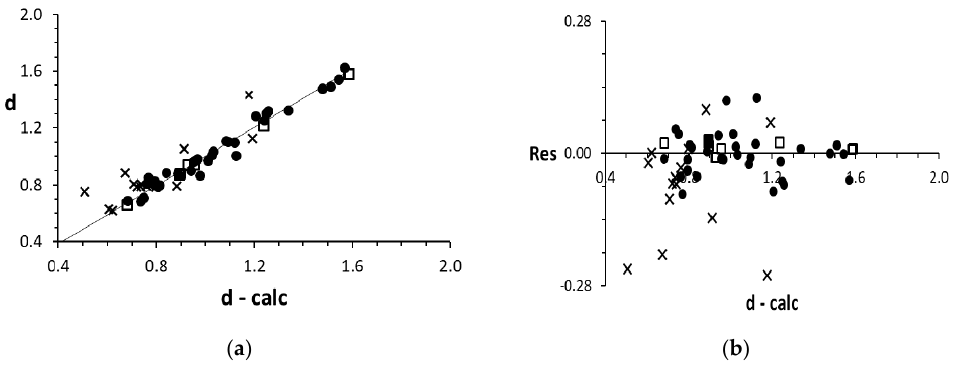
Figure 4. Plot of the Experimental vs. calculated (calc) density, d , ( a ) and the corresponding residual plot ( b ): (•) training points, ( □ ) test points, and ( × ) evaluated points. Statistics of EV points: N = 15, r 2 = 0.88, s = 0.1.